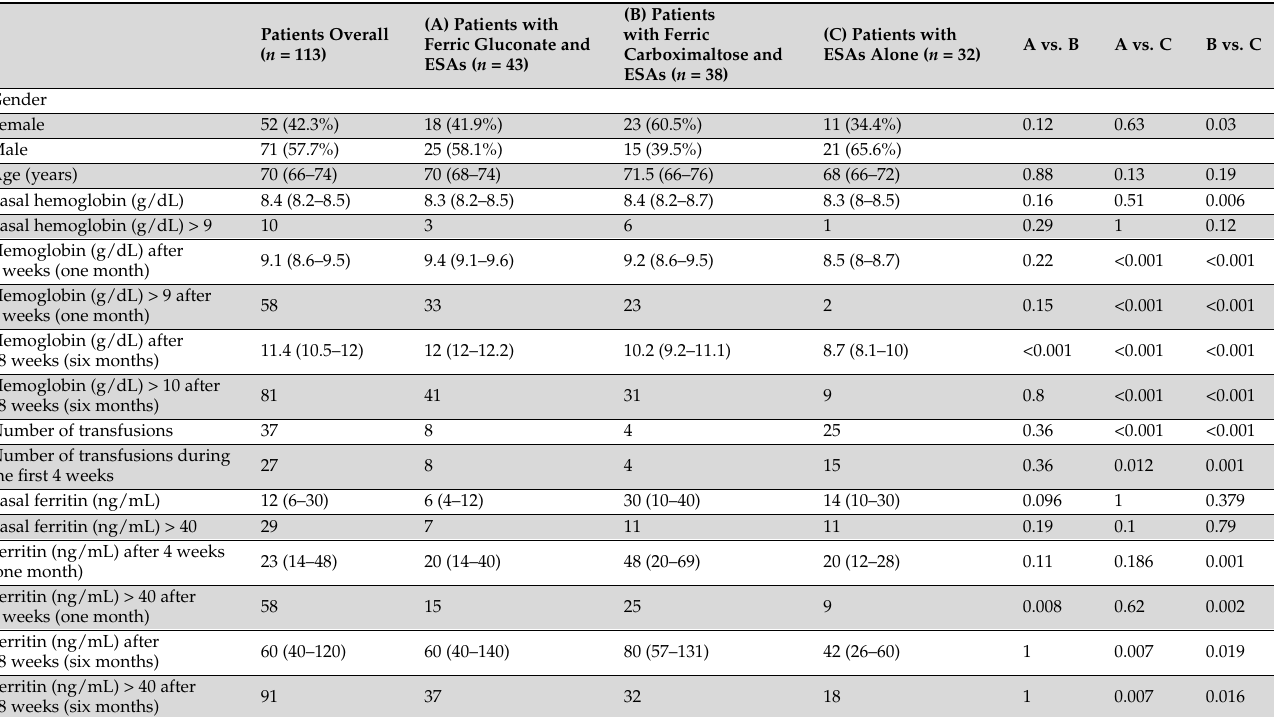
Table 1. Characteristic and laboratory exams of examined population and the three groups according to treatment. Continuous variables are expressed as “median